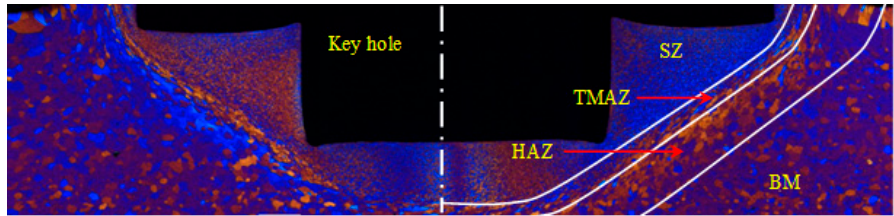
Figure 7. Typical microstructure of AA 6082 FSSW joint using process parameters: rotating speed 1600 rpm, plunge rate 72 mm/min, plunge depth 2.2 mm, and dwell time 3 s.